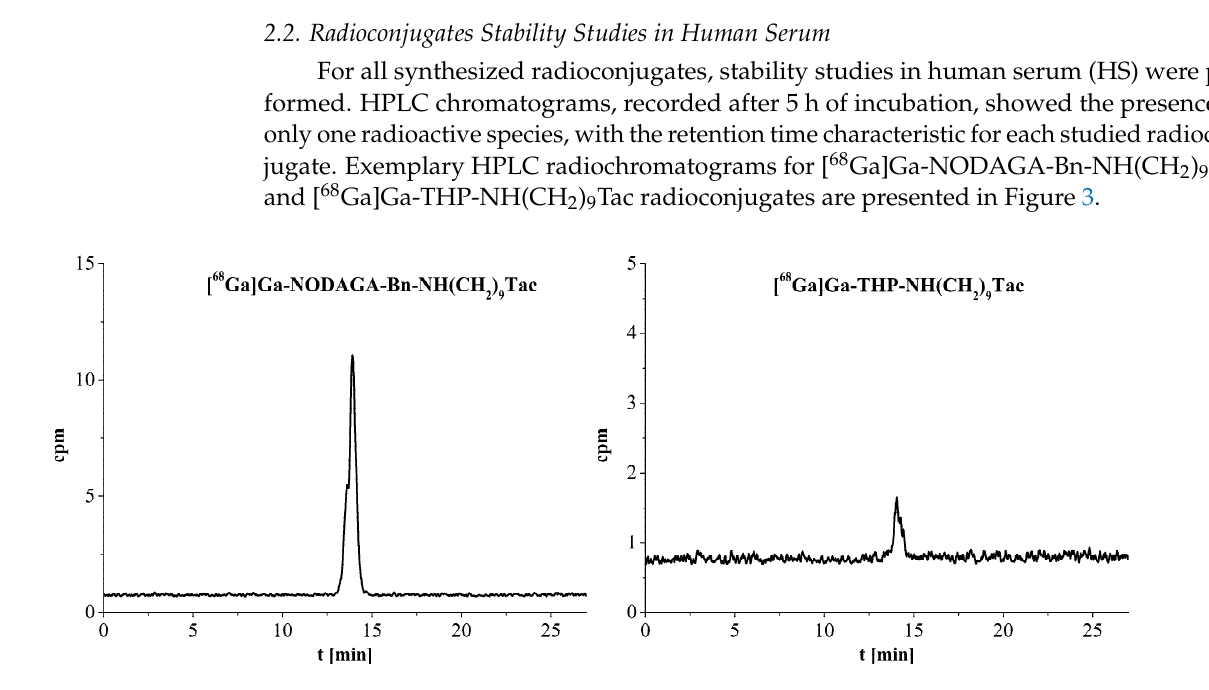
Figure 3. The HPLC radiochromatograms of [ 68 Ga]Ga ‐ NODAGA ‐ Bn ‐ NH(CH 2 ) 9 Tac and [ 68 Ga]Ga ‐ THP ‐ NH(CH 2 ) 9 Tac radioconjugates recorded after 5 h of incubation at 37 °C in human serum.